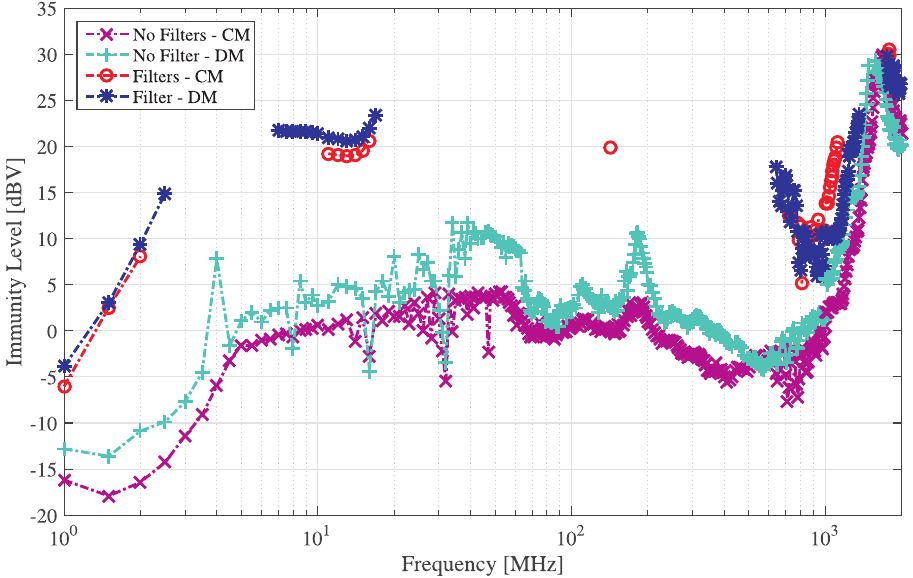
Figure 5. Total RF voltage induced at the DPI injection port corresponding to the DPI immunity levels in Figure